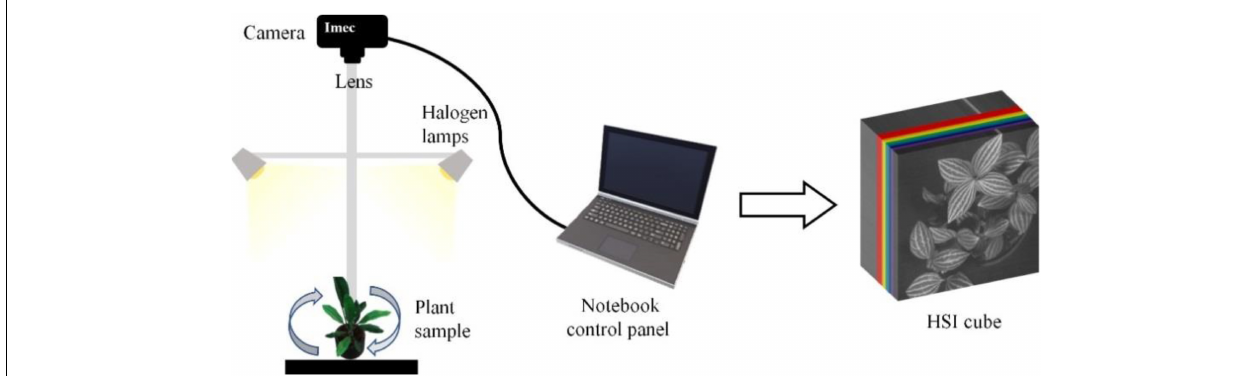
FIGURE 2 | Illustration of plant image acquisition.